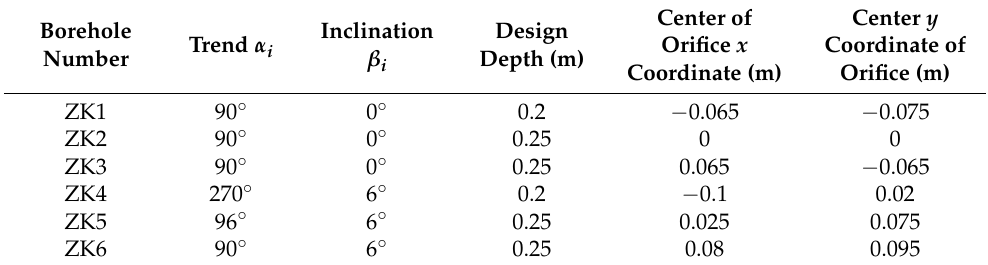
Table 2. Parameters of each borehole.